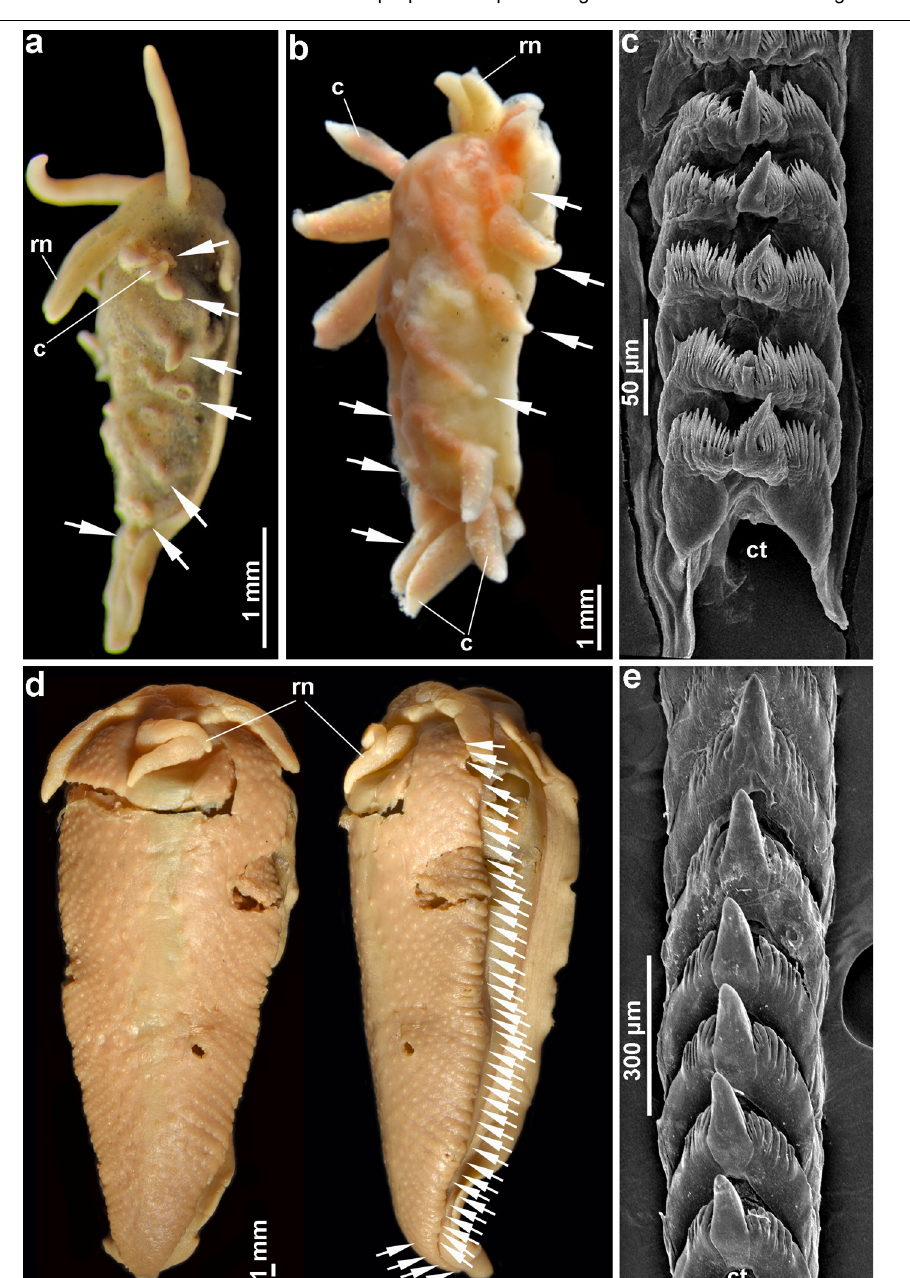
Fig 3. Comparison of phylogentically sister, complex non-burrowing Murmania antiqua (Martynov, 2006) (family Murmaniidae) from the Arctic Ocean with simplified facultative burrowing Xenocratena suecica Odhner, 1940 (family Xenocratenidae fam. n.) from the Atlantic (North Sea) waters of Sweden and Norway. The degree of simplification of ceratal (papillae-bearing) rows (every row is indicated by a separate arrow, majority of papillae were removed to clearly show the number of ceratal rows, which are counted according to the knob-like traces of the ceratal attachment on the dorsal side) can be evaluated directly between Xenocratena (A, B) and Murmania (D). Xenocratena (A, B) possesses no more than five (commonly fewer) of anterior ceratal rows and no more than eight (commonly fewer) ceratal rows in total. Murmania (D) possesses more than 20 anterior ceratal rows and more than 40 ceratal rows in total. Both small syntype (A, preserved specimen 4 mm in length) and newly discovered specimens (B, preserved, length 7 mm) specimens of Xenocratena suecica are compared with the large holotype specimen of Murmania antiqua (D, preserved, length 44 mm). The radular teeth of Xenocratena (C) and Murmania (E) are also presented to show the considerable morphological differences between these phylogenetically sister taxa. Abbreviations: c, cerata (dorsal papillae); ct, central teeth of radula; rn, rhinophores (chemical sense organs).